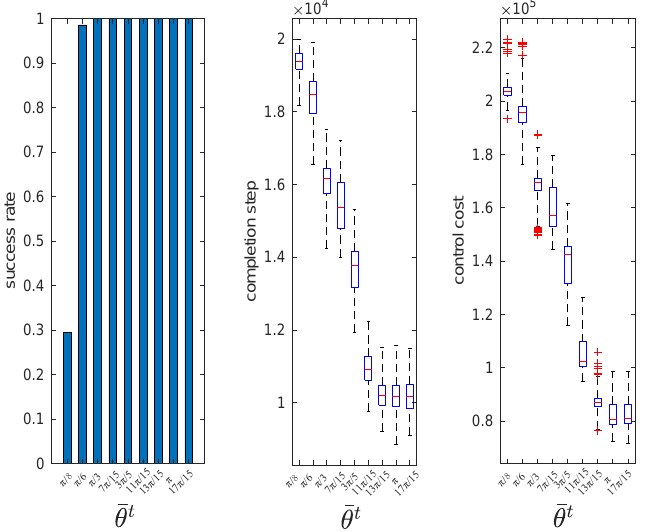
Figure 15. The algorithm performance with respect to the variations of ¯ θ t